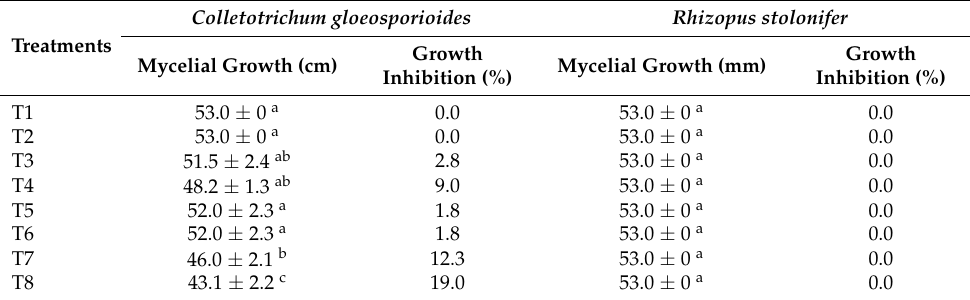
Table 2. Growth of Colletotrichum gloeosporioides and Rhizopus stolonifer in the presence of polymeric nets manufactured with 60/40 PLA/PPBAT + PEO at different concentrations + 1% chitosan for 10 h at 20 ◦